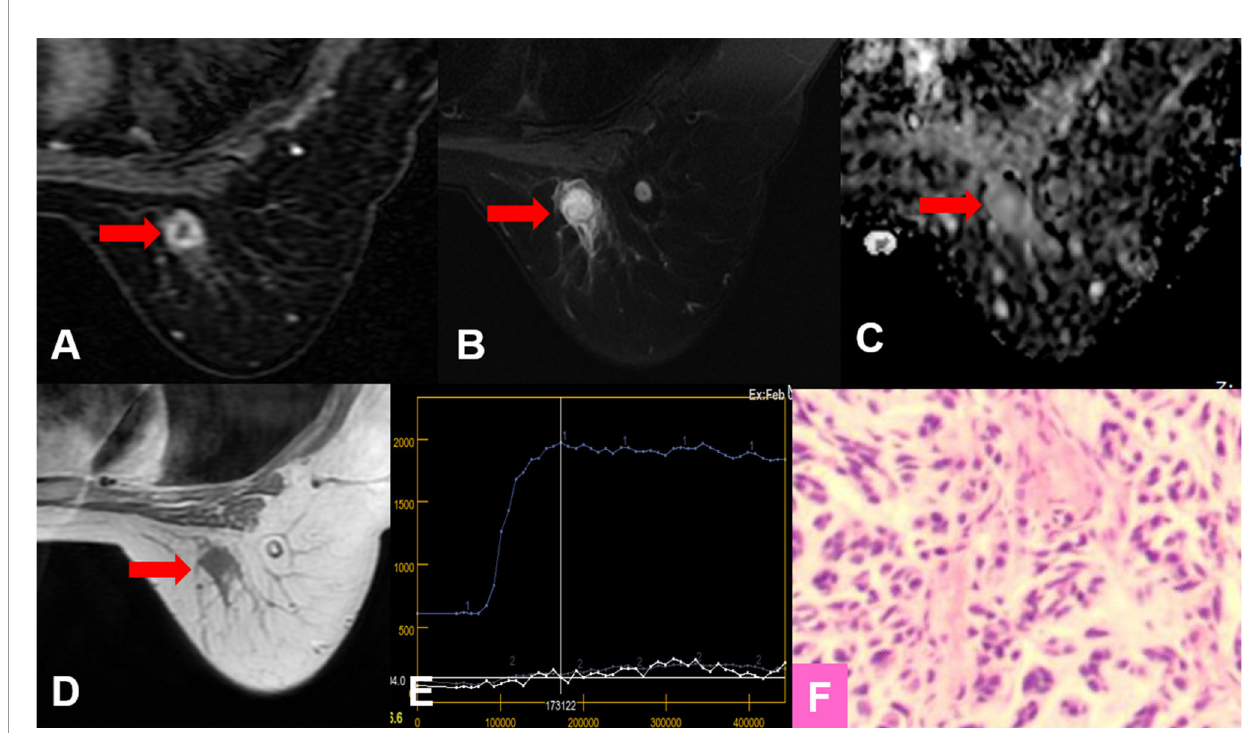
FIGURE 4 | True-positive KS and false-negative KS+ results. A 53-year-old female patient: MRI showed an irregular lesion in the right breast [ (A – D) , red arrow]. The lesion showed heterogeneous internal enhancement (A) , delayed plateau enhancement (E) , and without perifocal edema (B) . (A) Contrast-enhanced MRI, (B) T2WI with fat suppression, (C) ADC map, (D) T1WI, (E) TIC curve, (F) pathological image (H&E, 100×). Kaiser score = 5, ADC = 1.57 × 10 − 3 mm 2 /s. Histopathology revealed a metaplastic carcinoma (F) . Immunohistochemical results are as follows: ER, PR, and HER-2 were negative. Ki-67 expression was high (70%). Vimentin, S-100, and CK-Pan were positive. SMA, Desmin, EMA, CD34, p63, and p40 were